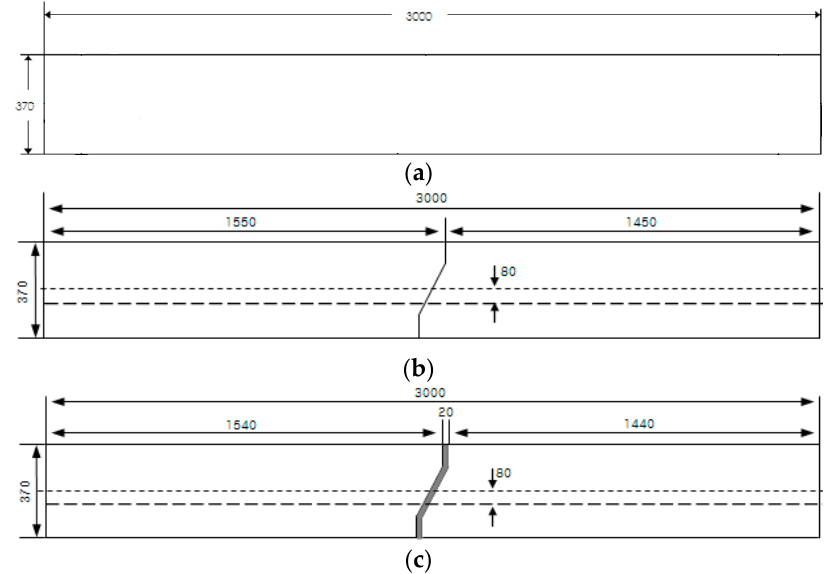
Figure 7. Specimen dimensions (unit: mm): ( a ) RC beam (G); ( b ) P-series; and ( c ) EP-series.